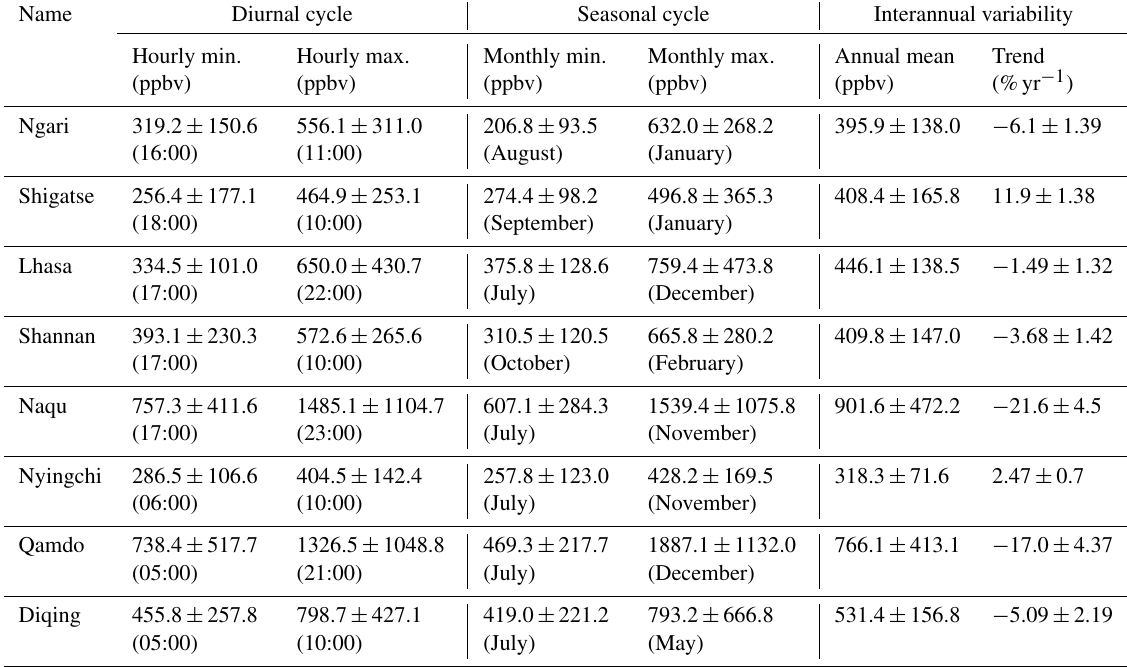
Table 3. Statistical summary of surface CO VMR in eight cities over the HTP region. All cities are organized as a function of increasing